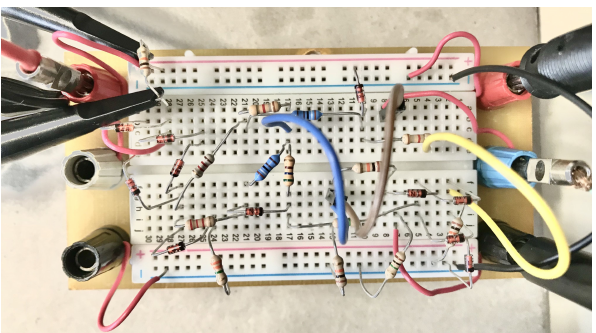
Figure 12. A bread-board implementation of a failure-resilient square root circuit.